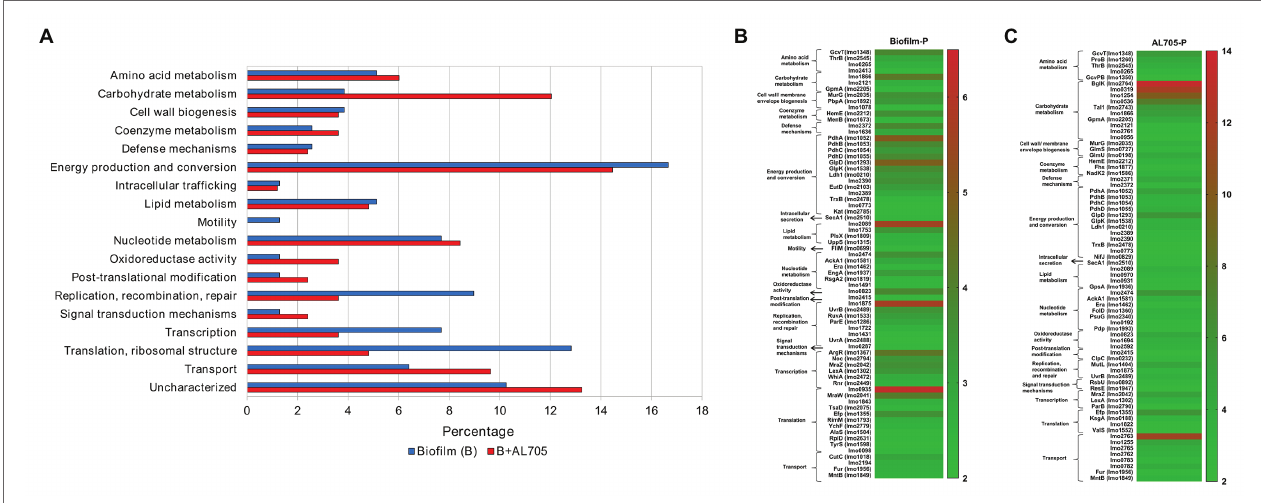
FIGURE 2 | Up-regulated proteins by L. monocytogenes FBUNT untreated and bacteriocin AL705-treated sessile cells compared to planktonic cells: Horizontal bar chart showing the functional categories and proteins percentages (A) and Heat-map illustrating the fold change of the statistically significant overexpressed proteins in untreated (B) and treated (C)